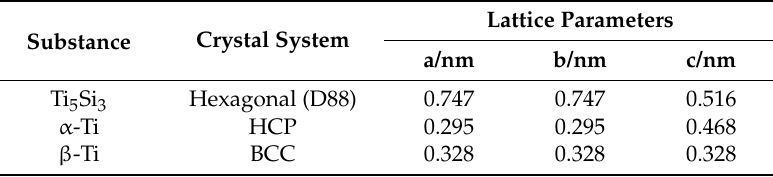
Table 1. Lattice parameters of different